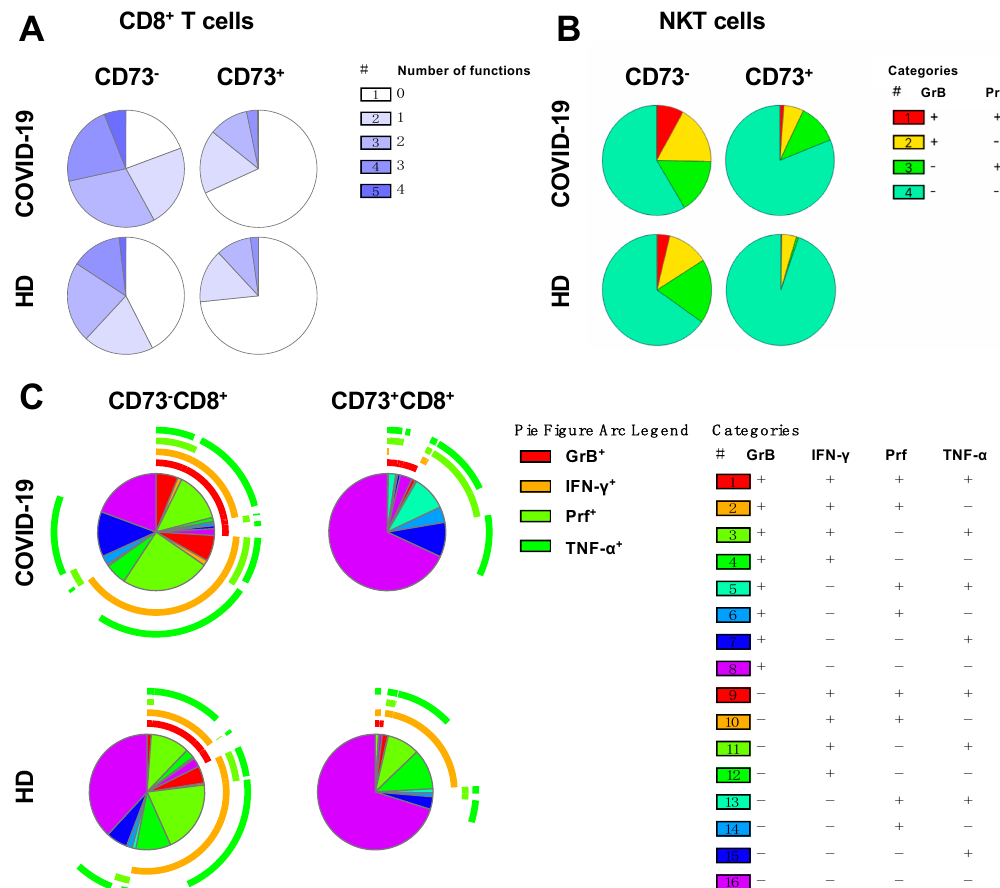
Figure 6. SPICE analysis of TNF- α , IFN- γ , granzyme B (GrB) and perforin (Prf). The pie charts represent the proportions of CD73 - CD8 + T and CD73 + CD8 + T cells with single, double, triple or quadruple functions upon stimulation ( A ). Single or dual (red) secretion of GrB and perforin by CD73 - NKT and CD73 + NKT cells upon stimulation ( B ). Di ff erent combinations of TNF- α , IFN- γ , GrB and perforin secretion by CD73 - CD8 + T and CD73 + CD8 + T cells ( C